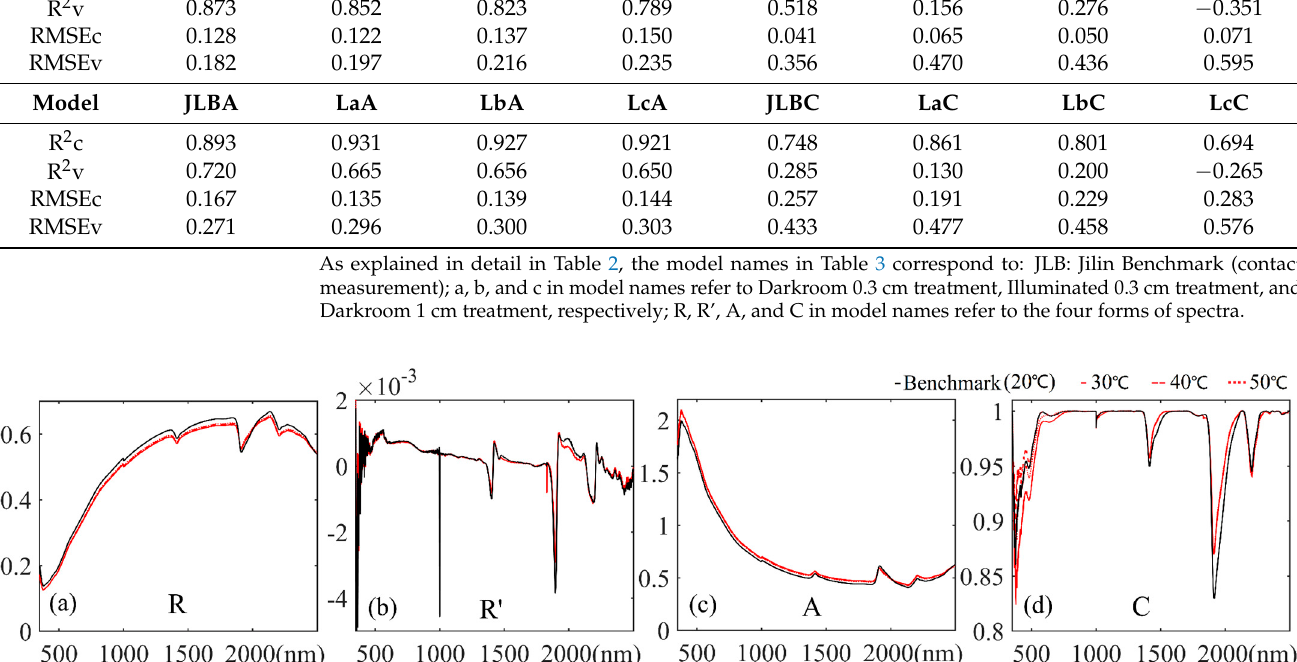
Figure 9. Average spectra of JL samples in soil temperature control experiments: ( a ) spectral reflectance (R); ( b ) the first derivative of the reflectance (R’); ( c ) the spectral absorbance (A); ( d ) the spectra of continuum removal (C).